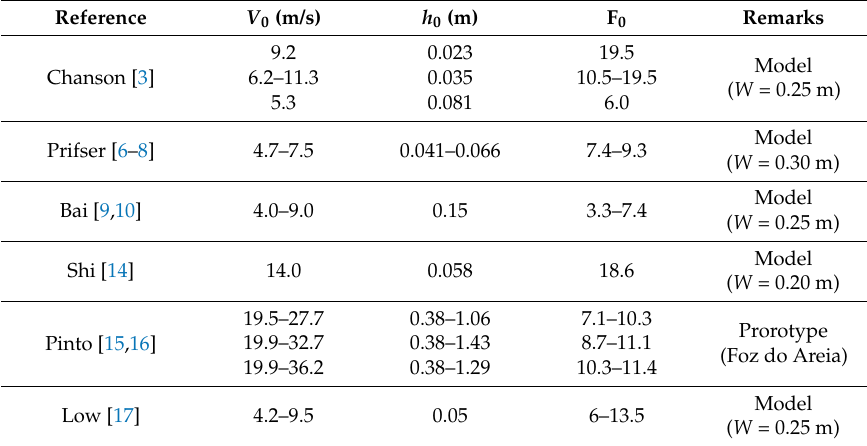
Table 1. Experimental investigations of Chute